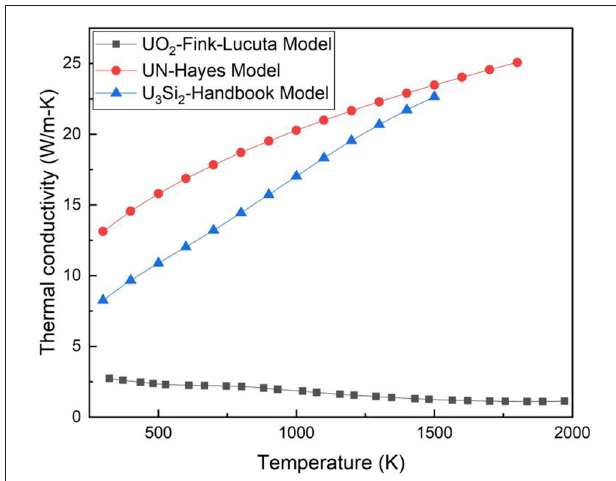
FIGURE 2 | Thermal conductivities of fresh U 3 Si 2 (White, 2018), UN (Hayes et al., 1990a ), and UO 2 (Williamson,